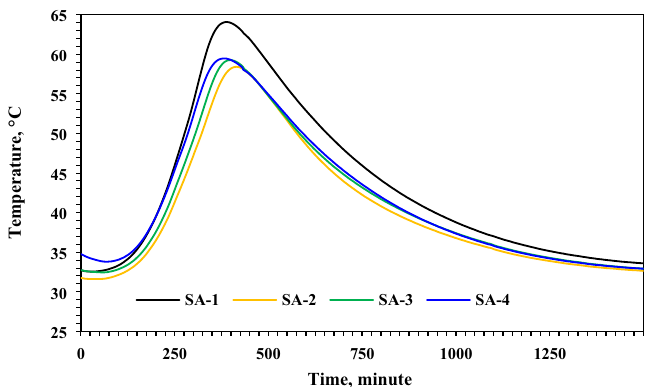
Figure 2. Hydration of cement mortar containing aerogel and sonicated and un-sonicated CNTs.